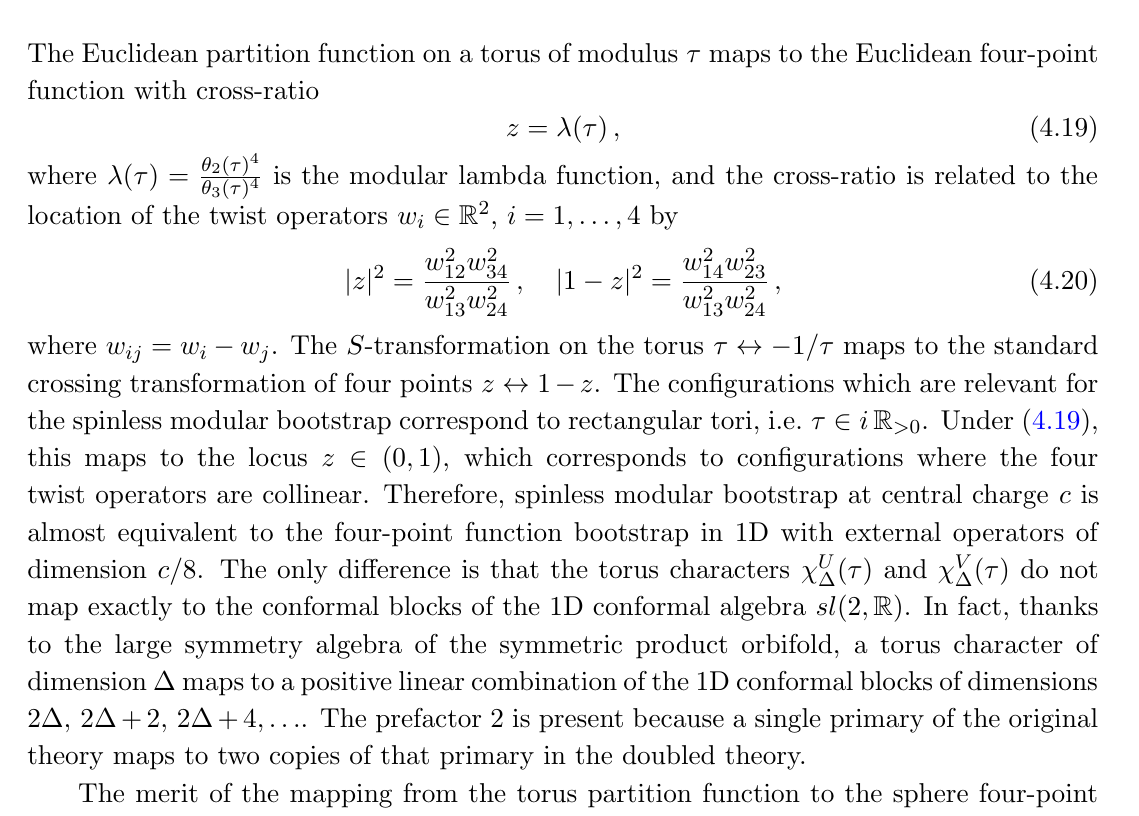
Figure 3 . Upper bounds from linear programming on the gap for U(1) c and Vir c , denoted (cid:1) U ( c ) and (cid:1) V ( c ). We have subtracted c +4 from both bounds. c +4 is the optimal bound in the case of 8 8 the four-point function bootstrap in 1D, translated to modular bootstrap